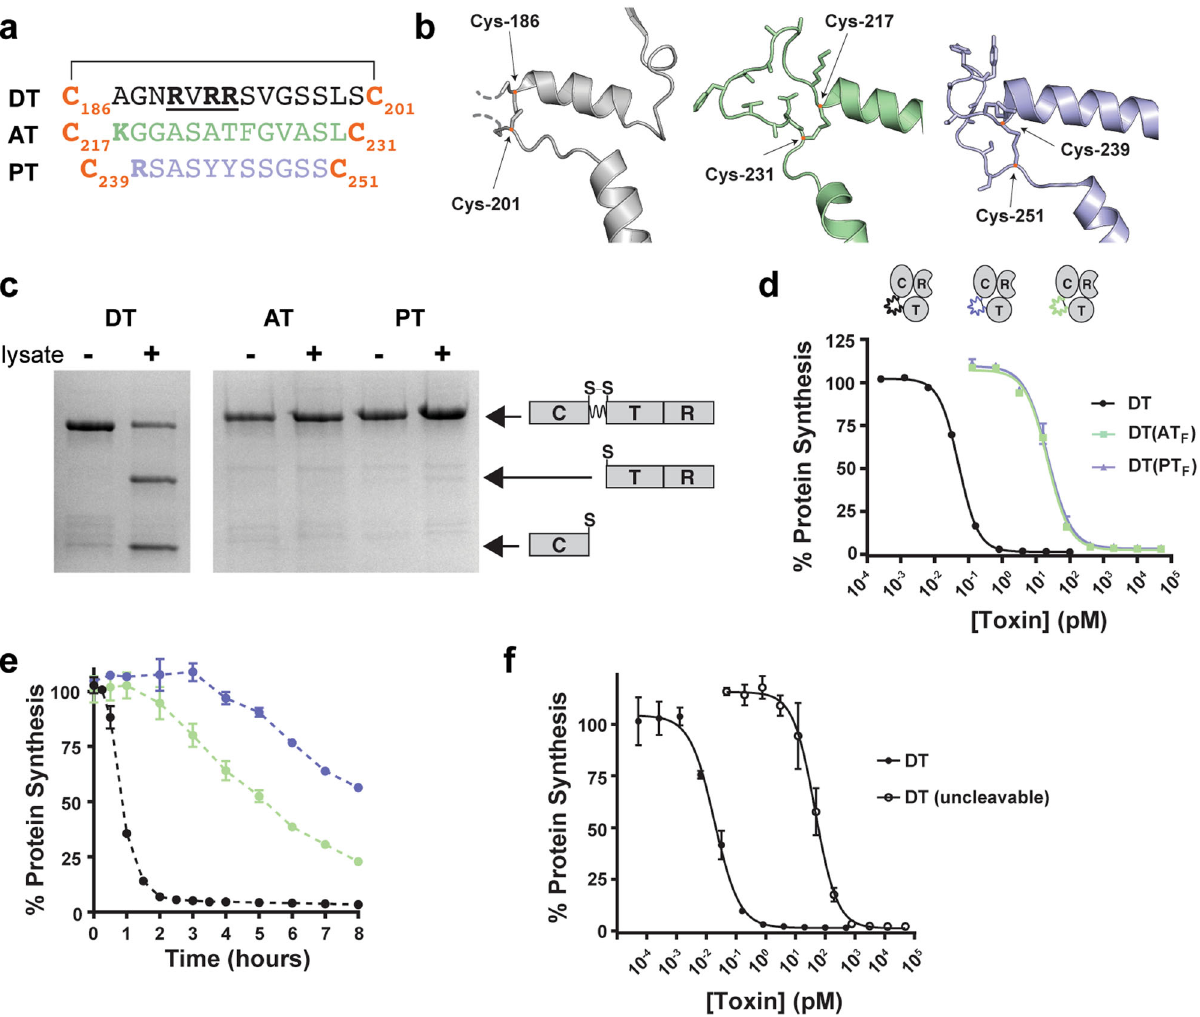
Fig. 5 AT and PT are not ef fi ciently processed. a Primary amino acid sequences of loops linking C and T domains in DT, AT, and PT. b Structures of processing sites in DT, AT, and PT in gray, green, and purple, respectively. c SDS-PAGE analysis of holotoxin processing by Vero cell lysate. d Dose titration of DT and DT activation loop chimeras DT(AT F ), DT(PT F ) on Vero cells (mean ± SD, n = 2); n = 3 biological replicates. e Time course of protein synthesis inhibition in Vero cells treated with 10 nM of DT, DT(AT F ), and DT(PT F ) (mean ± SD, n = 2); n = 3 biological replicates. f Dose titration of DT and DT (uncleavable) on Vero cells (mean ± SD, n = 4); n = 3 biological